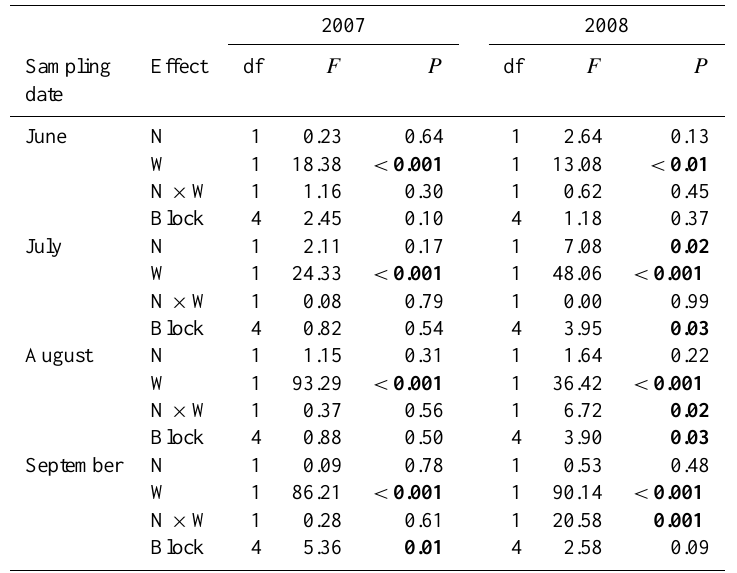
Table 2. Results from two-way ANOVA testing effects of nitrogen (N) and water addition (W) on aboveground plant biomass in 2007 and 2008. Significant effects ( P < 0 . 05) are indicated in bold.